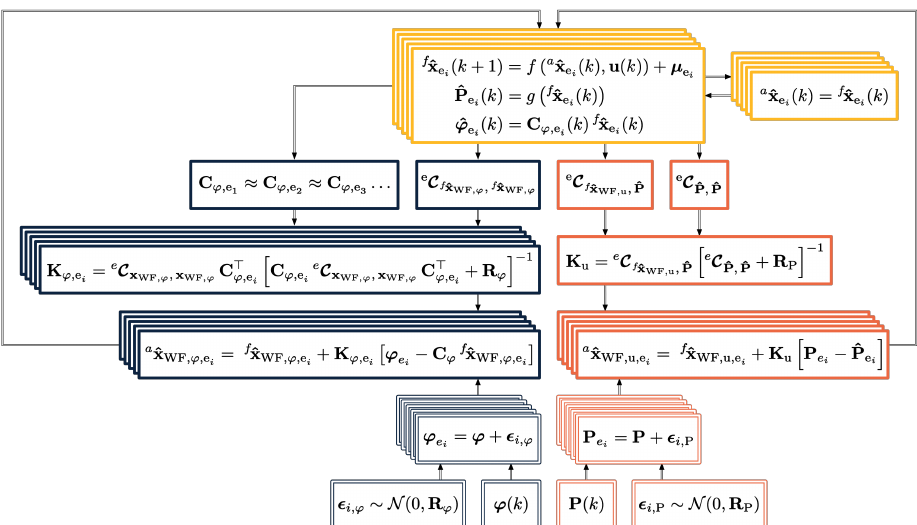
Figure 3. Block diagram of the correction across all ensembles. The yellow, top boxes describe all ensembles, running in parallel. If no measurements are given, the forecast state is used as an analysis state, and the ensembles diverge further. If measurements are given, the wind speed (orange) and direction (dark blue) states are corrected. The measurements and their perturbations are given at the bottom of the figure with thin double lined frames. Without perturbation, the variance of the ensembles would become too low